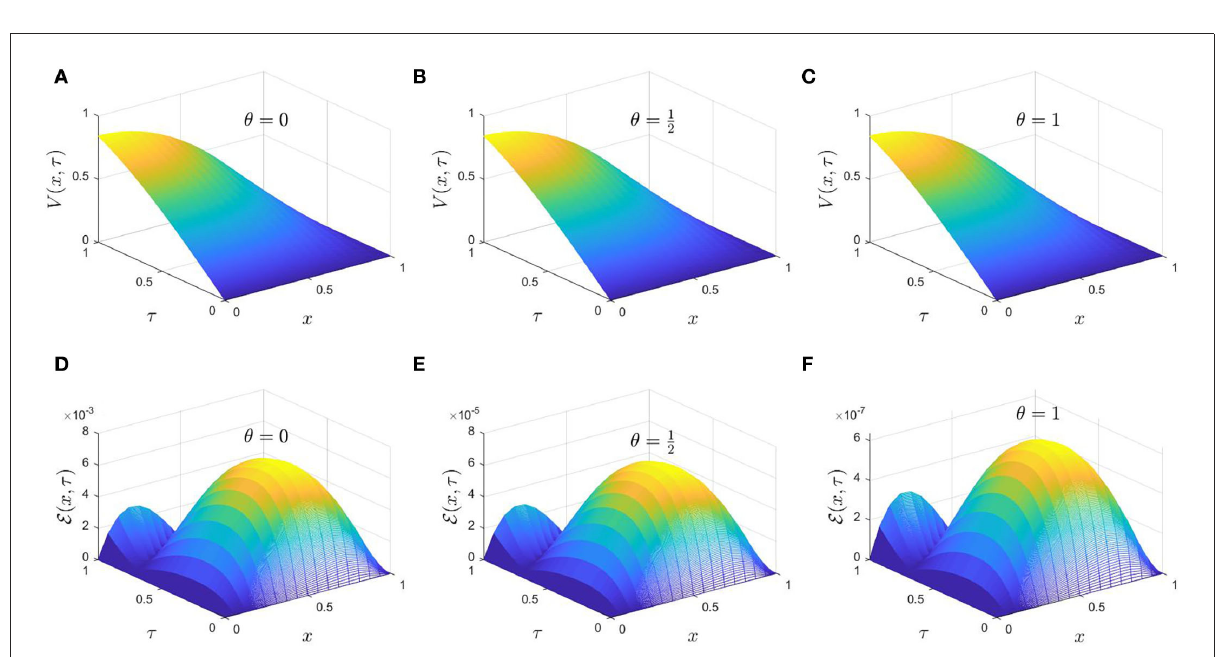
FIGURE6 (A–F) The numerical solutions of V ( x , τ ) of Example 2 for θ